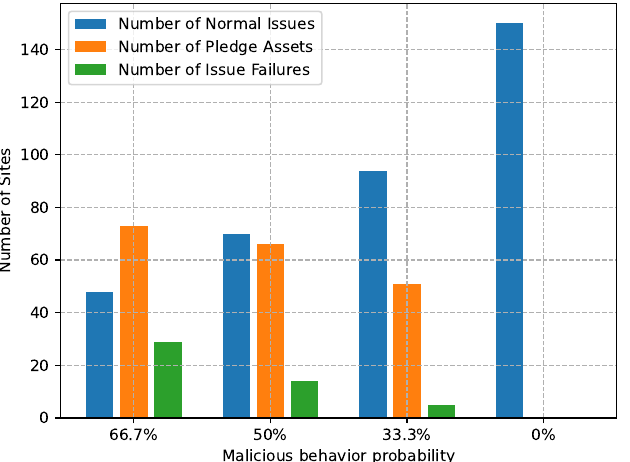
Figure 6. Parasitic Chain Attack